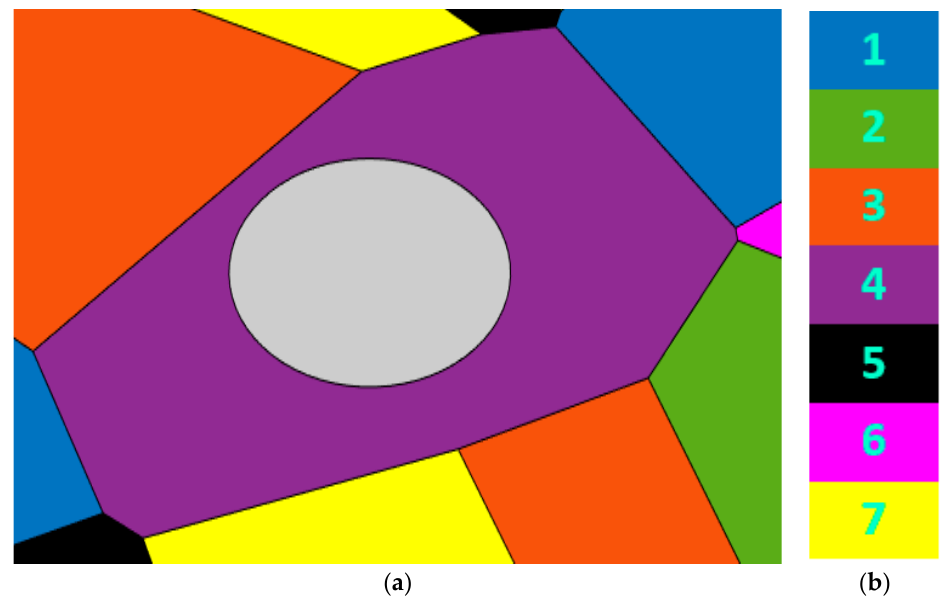
Figure 3. ( a ) A real example demonstrating a SC (the purple SC) with the center region (the grey region); ( b ) the seven used sub-bands.